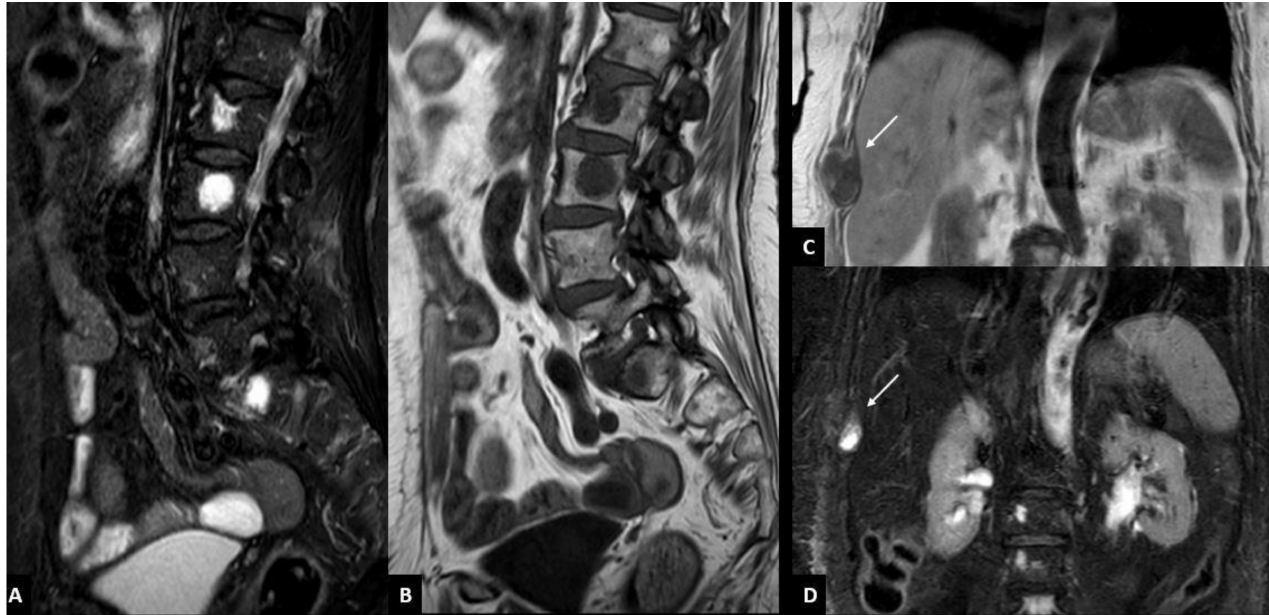
Figure 3. Focal infiltration pattern of multiple myeloma characterized by bone lesions of the spine ( A , B ) and the rib ( C , D ). Focal bone lesions of the spine are visible as a focal area of hypointensity on T1-weighted turbo spin-echo sequence ( A ) and of hyperintensity on T2-weighted short-tau inversion recovery (STIR) sequence ( B ) in L2, L3, and S1. Focal bone lesion of the rib is visible as focal area (arrow) of hypointensity on T1-weighted turbo spin-echo sequence ( C ) and of hyperintensity (arrow) on T2-weighted short-tau inversion recovery (STIR) sequence ( D ) in the costal angle of the ninth right